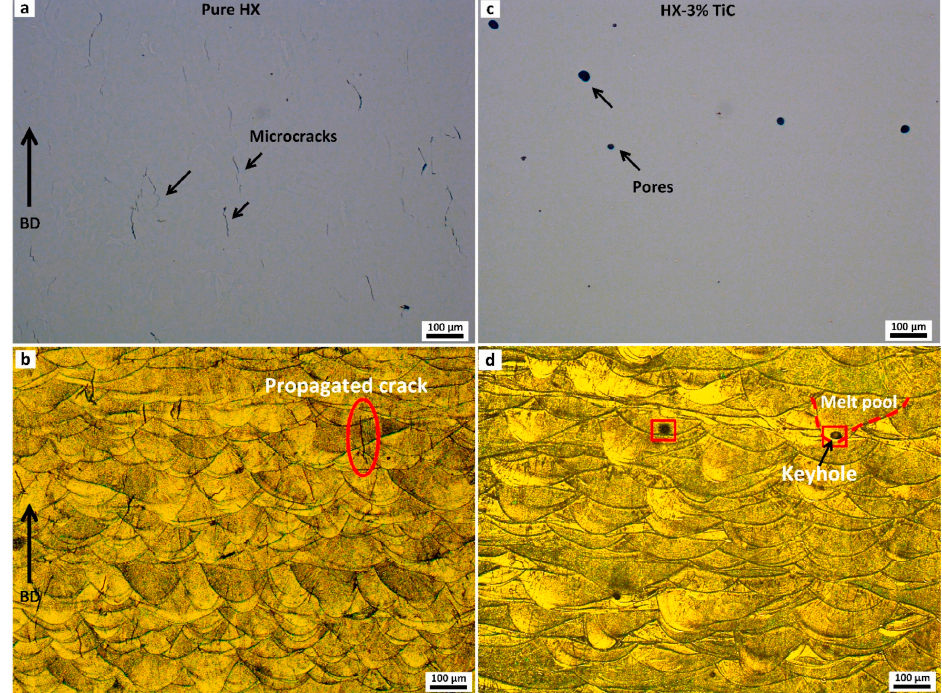
Figure 10. Defect distribution and molten pools in the built samples under optimum conditions: ( a , b ) Hastelloy X; ( c , d ) Hastelloy X matrix composite [72].